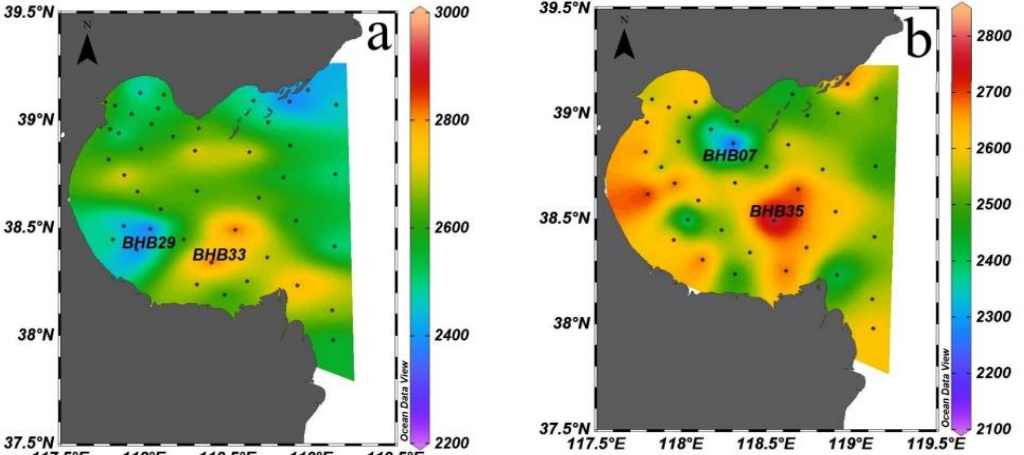
Figure 4. Horizontal distributions of Alk (µmol/kg) in the surface seawater ( a ) and bottom seawater ( b ) in Bohai Bay in summer 2020. The scale is 1:3,700,000. This image was created with ODV software, version 5.3.0 (Alfred Wegener Institute, Bremerhaven, Germany).